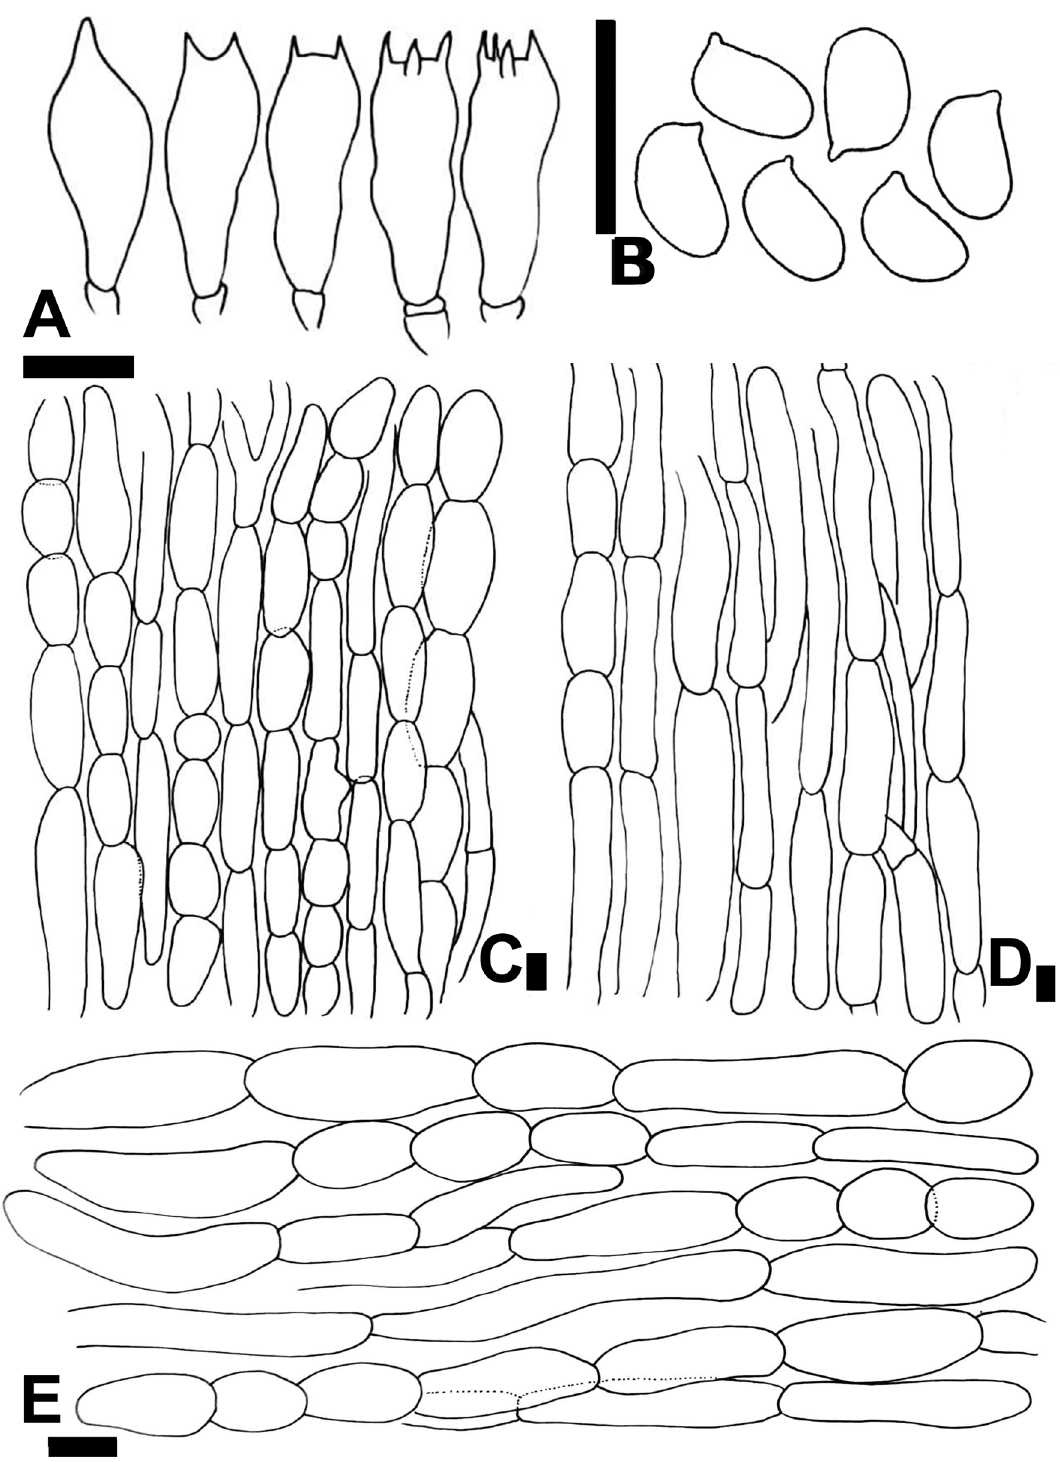
Figure 8. Micromorphological characters of A. fumidicolor. (A–E) CM17 ( Holotype ). (A) Basidia, (B) Basidiospores, (C) Pileipellis hyphae, (D) Stipitipellis hyphae, (E) Hyphae of the underside of the annulus. Bars = 10 µm. Drawings by Dr. Hira